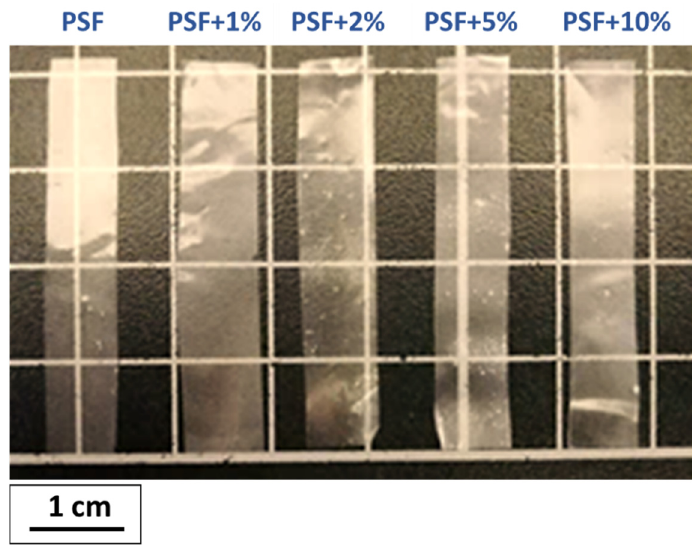
Figure 2. Photograph of the specimens prepared for mechanical tests.